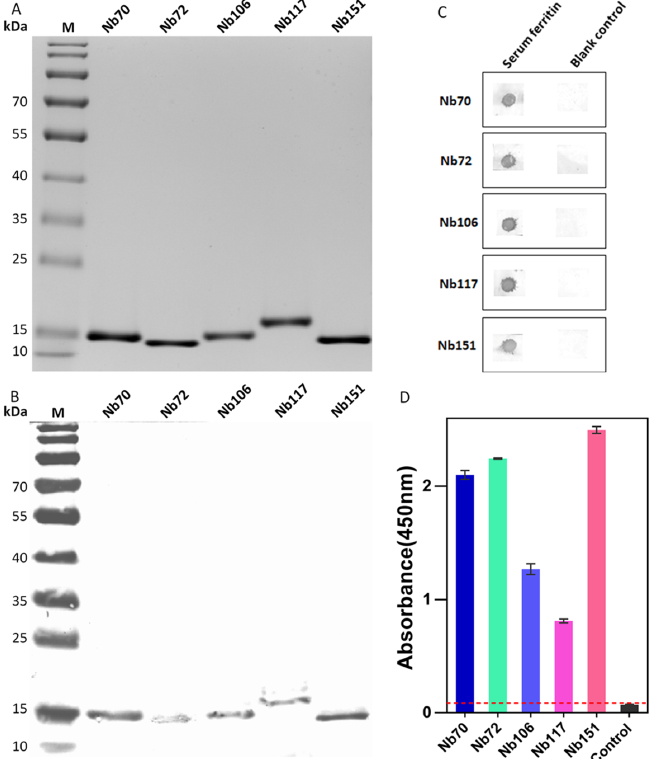
Figure 5. Preparation and characterization of selected Nbs fused with only His-tag. ( A ) The purity and molecular size of His-tagged Nbs was confirmed by SDS-PAGE. ( B ) The identity of